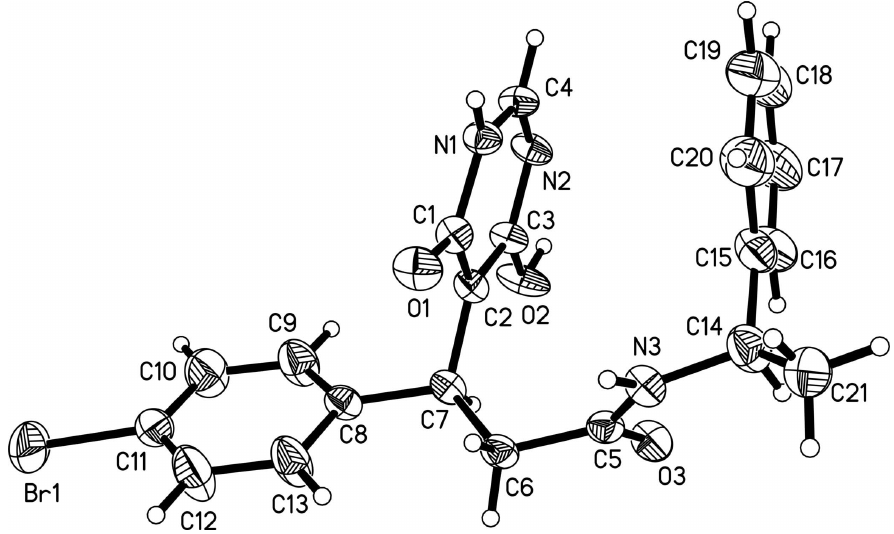
Figure 1 The molecular structure of the title molecule, with the atom-numbering scheme. Displacement ellipsoids are drawn at the 50% probability